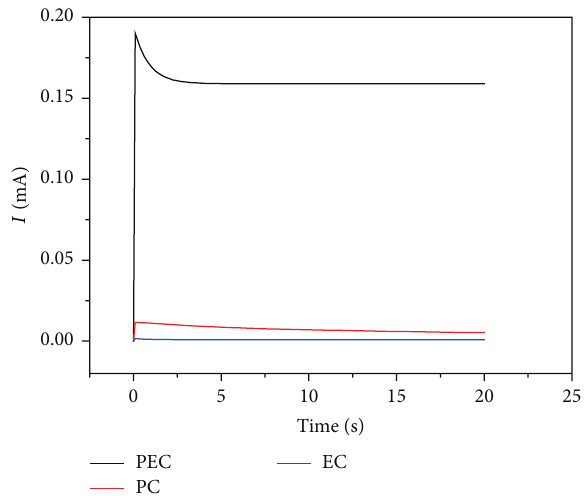
Figure4:Degradationof25 mg/LFAusingdifferentprocessinthin- layer reactor.